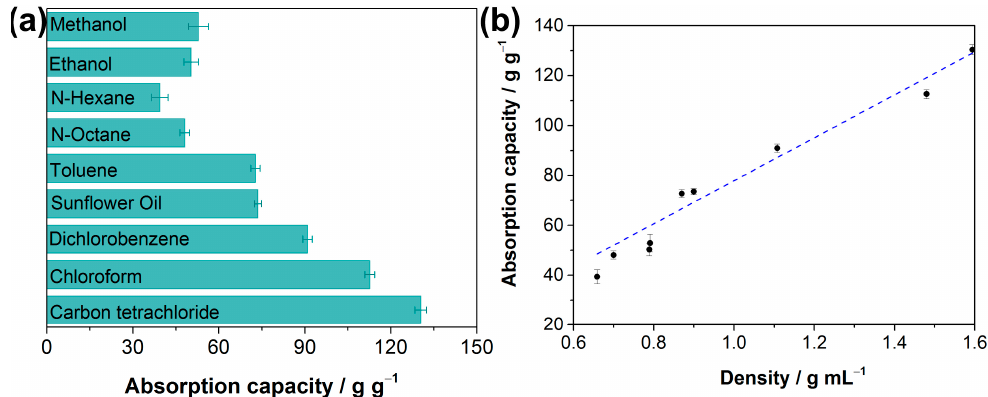
Figure 6. ( a ) Absorption capacities of the F-ZIF-90@PDA-MF sponge toward oil and organic solvents and ( b ) its correlation with di ff erent solvent density. Table 1. Comparison of oil absorption capacities and water contact angles of various metal − organic frameworks (MOF)/sponge composite materials.